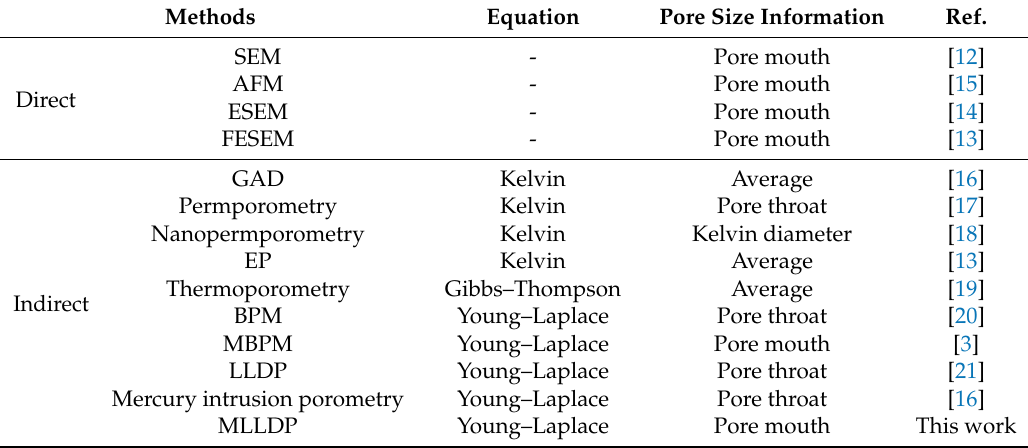
Table 1. Comparison of existing pore size characterization